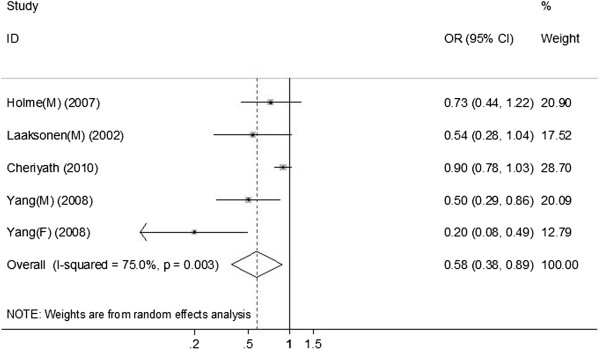
Forest plots for the risk of MS associated with the high level LPA. CI, confidence interval; LPA, leisure-time physical activity; MS, metabolic syndrome, OR, odds ratio.